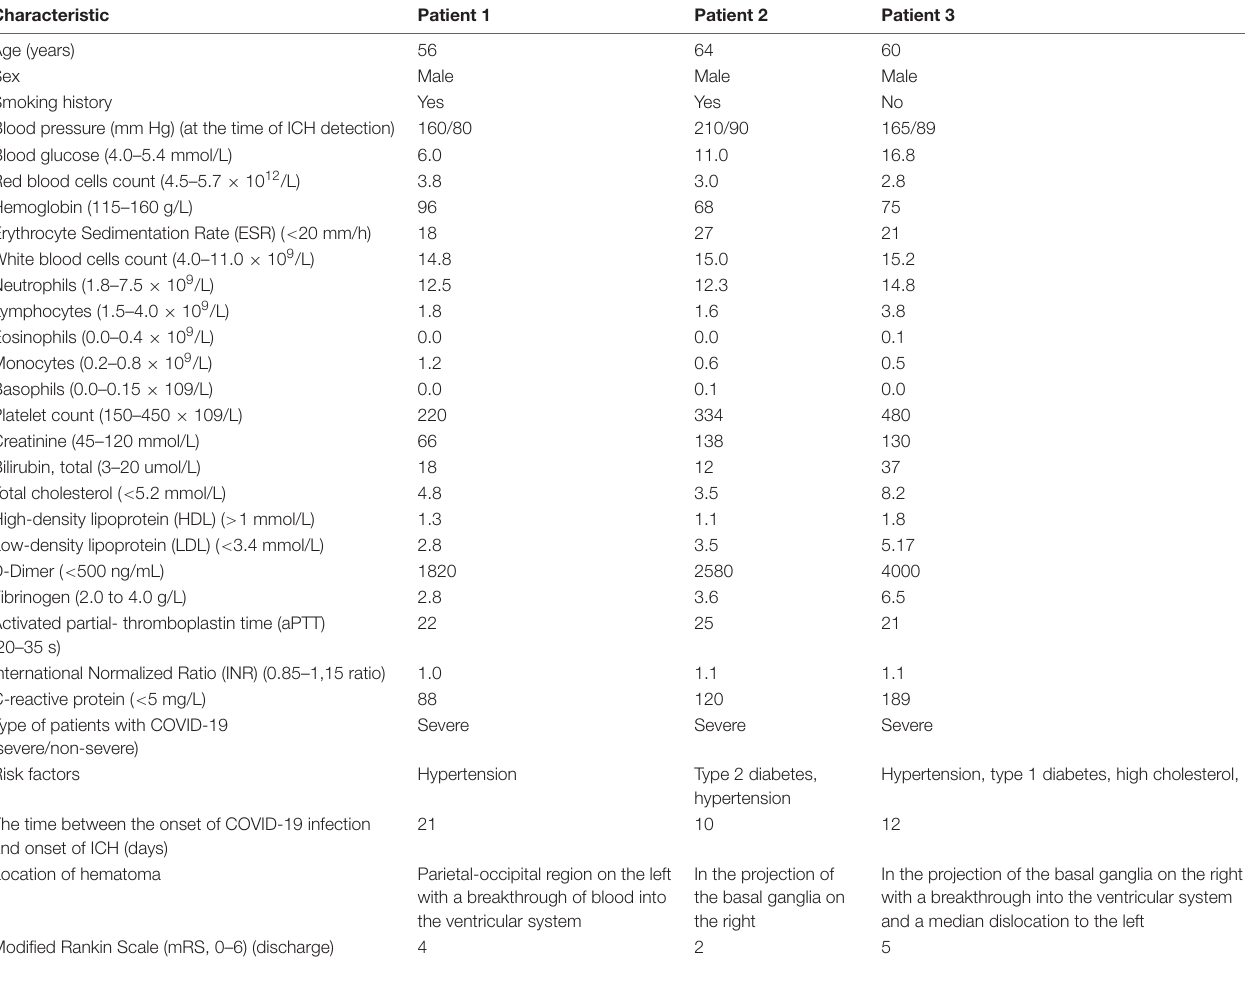
TABLE 2 | Baseline characteristics of patients COVID-19 with new onset of ICH during infection.